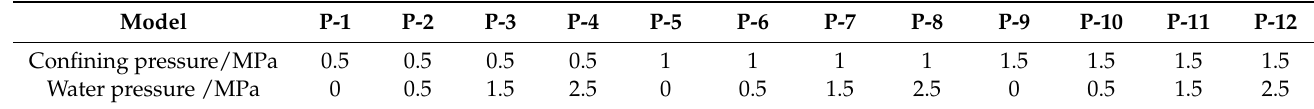
Table 2. Setting of confining and water pressures.